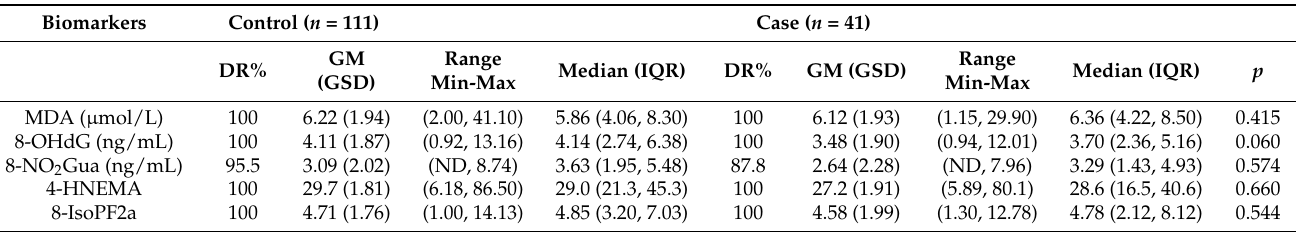
Table 3. Distribution of urinary phthalate metabolites and oxidative/nitrosative stress biomarkers in the case and control groups